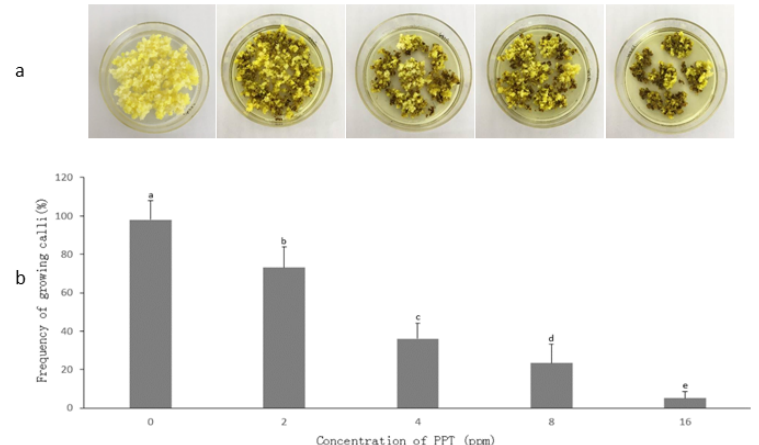
Figure 4. Selection effect of PPT concentrations on calli of Veratrum dahuricum after 4-week culture. ( a ) Calli on selection medium with different PPT concentrations, ( b ) selection efficiency of different PPT concentrations (n = 690). Treatments (means ± SD) followed by a different letter are significantly different according to the LSD test ( p < 0.05).